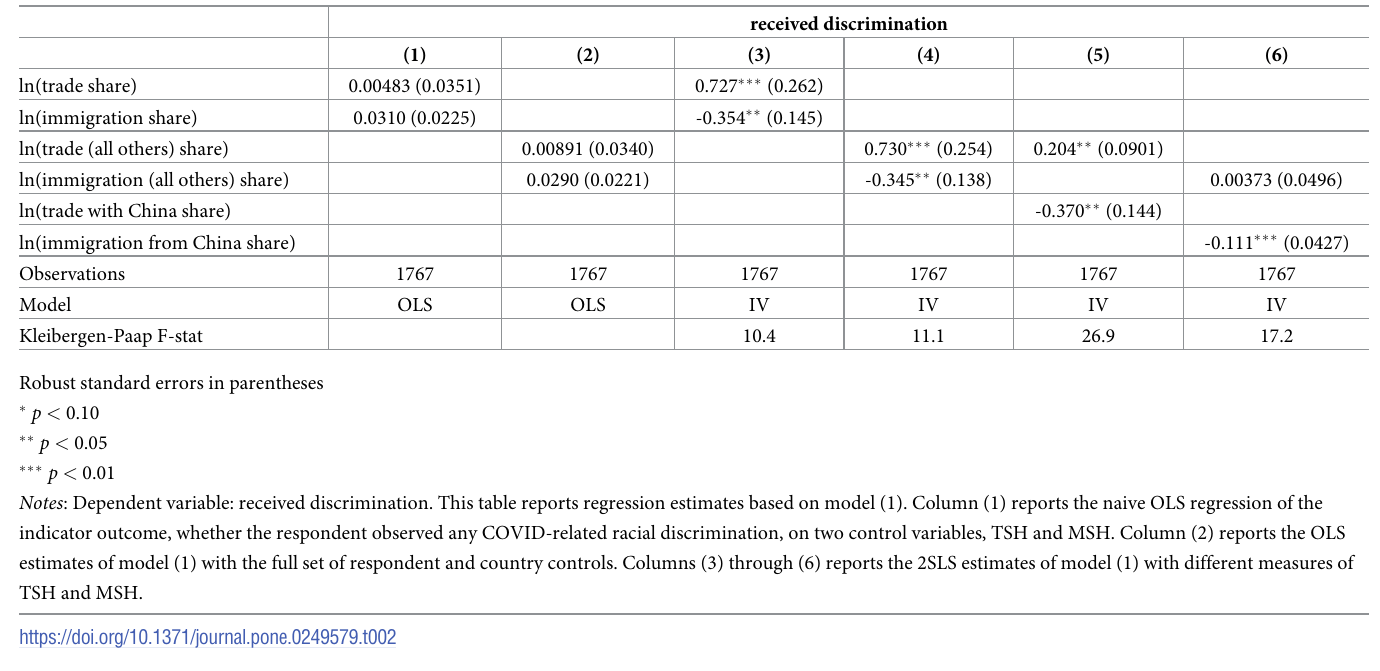
Table 2. Discrimination, openness to trade and